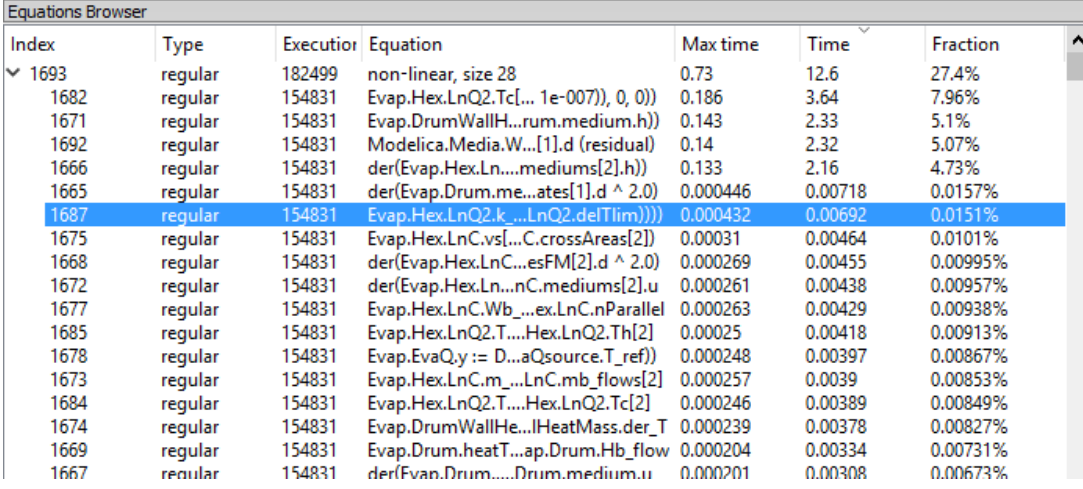
Figure 15: Close-up of performance pro(cid:28)ler output after a minor model adjustment. The 28 equations at Index 1693 use 27.4% of the